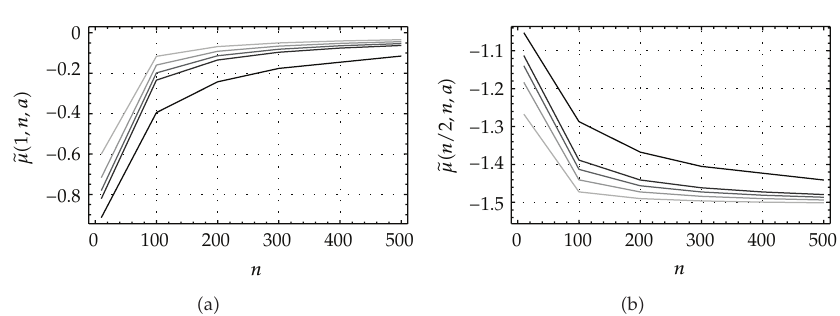
Figure 2: Dependence of (cid:2) μ (cid:2) 1 ,n,a (cid:3) and (cid:2) μ (cid:2) n/ 2 ,n,a (cid:3) on n for a (cid:4) 10 , 20 , 30 , 40 , 100. Plots are shown in gray- level intensity, from lower to higher, according to the value of a